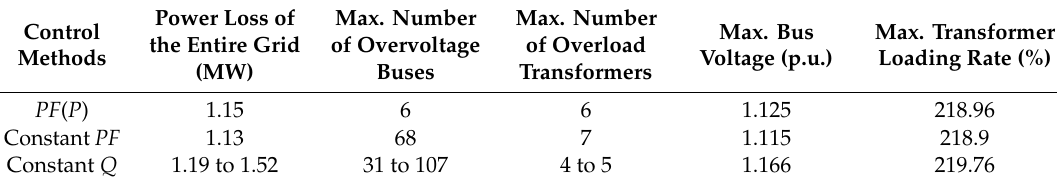
Table 3. The summary of the case studies with a PV penetration level of 40%.